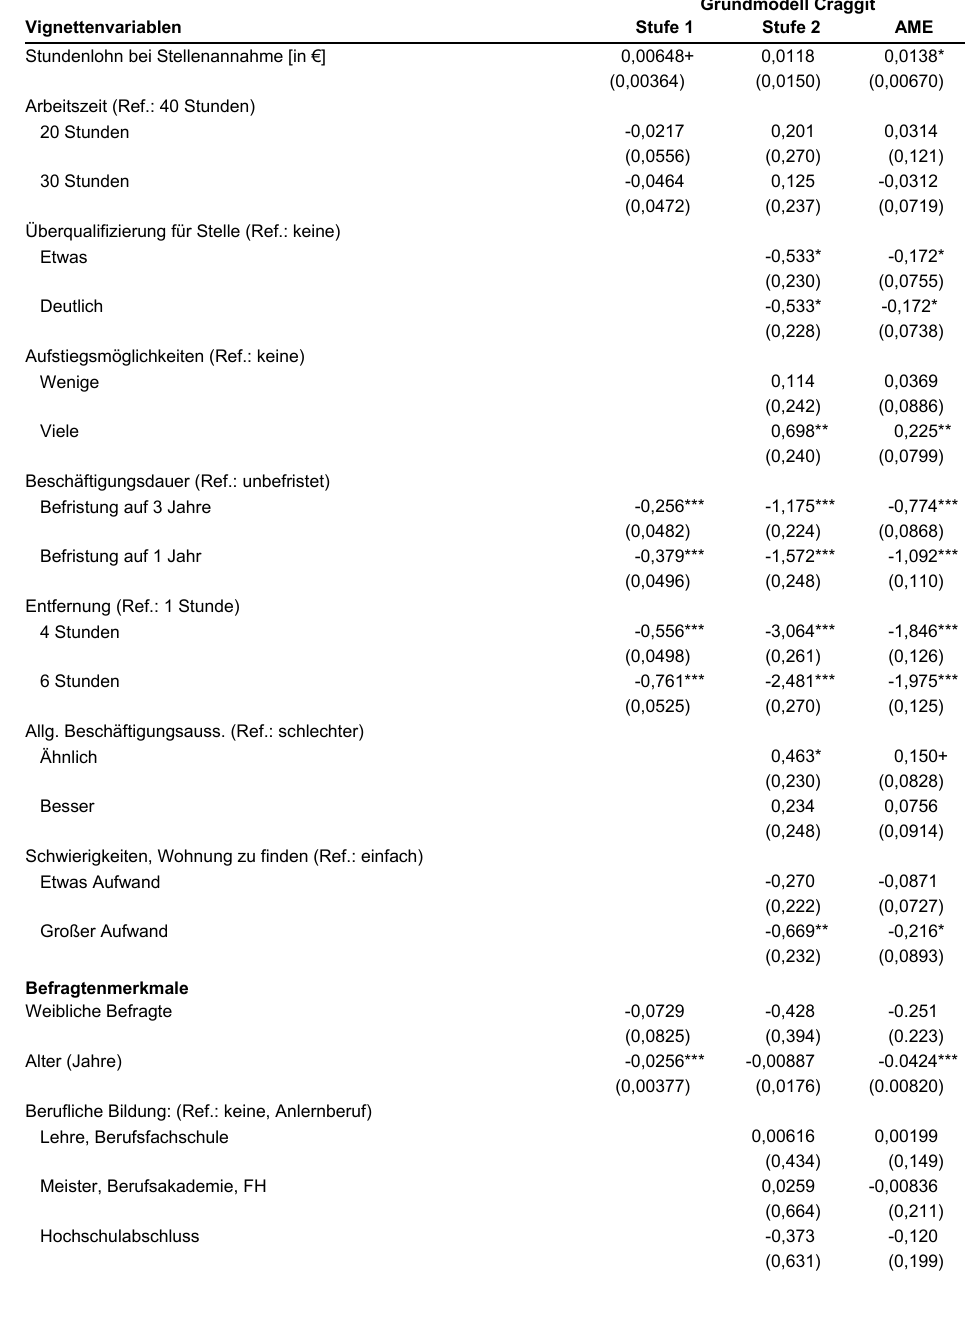
Tabelle A3 : Craggit-Modell, abhängige Variable „Stellenannahmebereitschaft“ (Koeffizienten bzw. AMEs; in Klammern geclusterte Standardfehler)